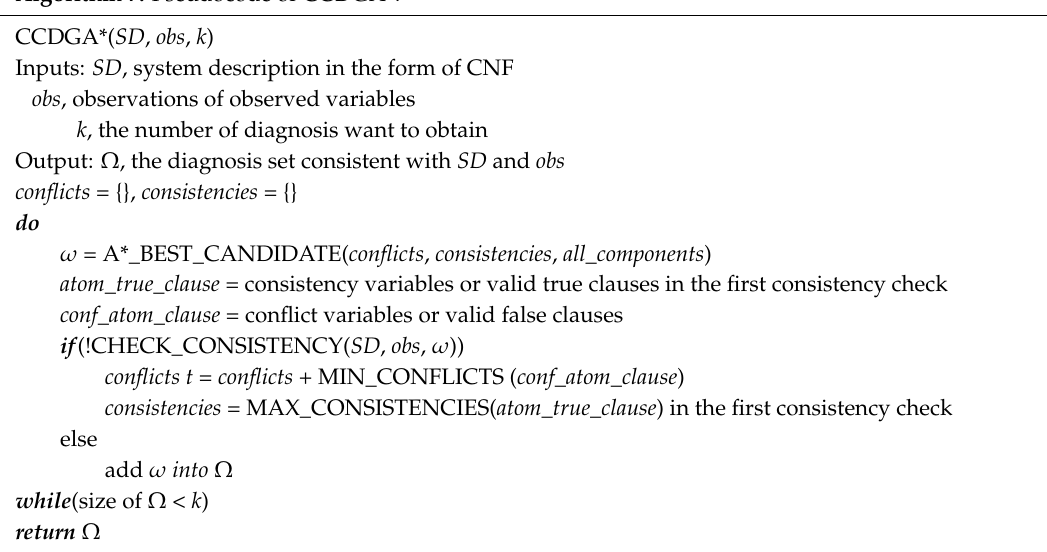
Algorithm 7. Pseudocode of